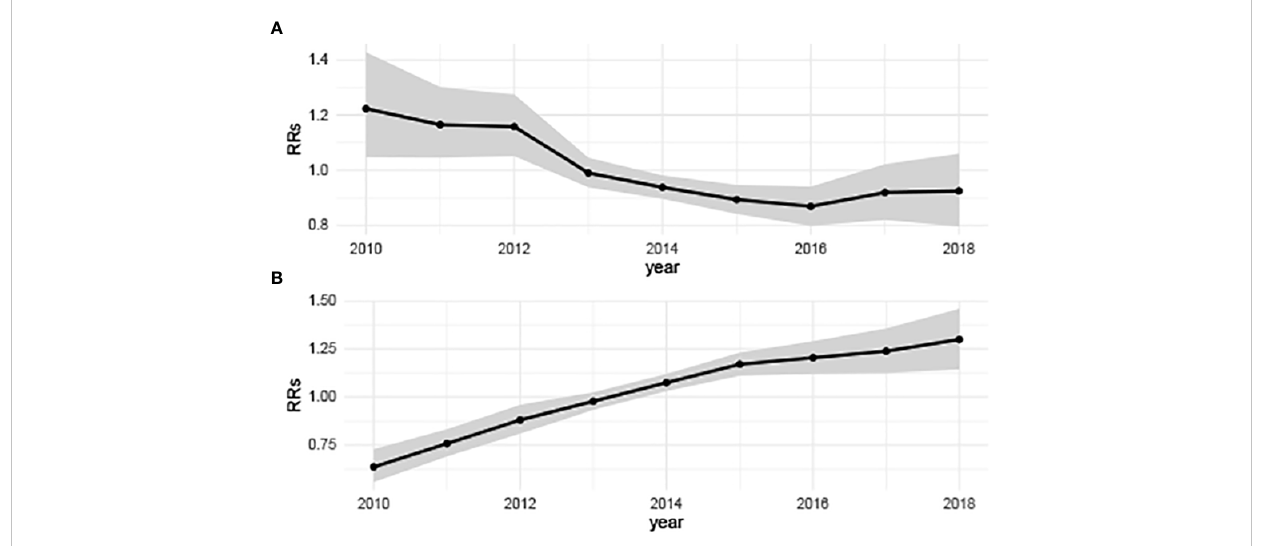
FIGURE 3 Annually temporal relative risks of hepatitis B and hepatitis C in China from 2010 to 2018. (A) Hepatitis B, showing a slow downward trend; (B) Hepatitis C, showing a signi fi cant upward trend. ( b 0 t *+ v t ) describes the overall time trend common to all counties with v t e N (0, s 2 v